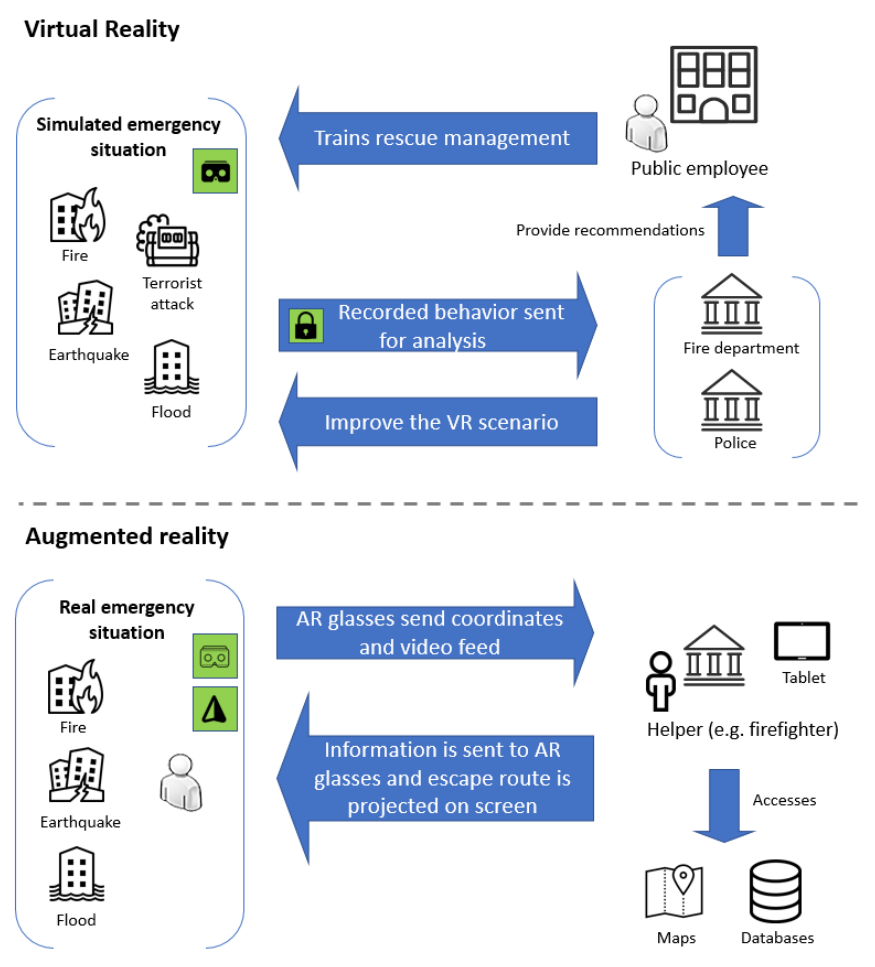
Figure 2. Scenario poster – “Virtual Reality and Augmented Reality for emergency training" As described in the methodology, the scenario provides an example of possible future implemen- tations of disruptive technologies in public service provision. While most of the relevant technolo- gies can be implemented today, there are still aspects that need to be developed further (e.g. room mapping technology (3D scanning and creation of virtual spaces based on real ones) is still costly to realise). The next two sections outline the main research and training needs (step 4 of the approach) extracted from the thirteen scenarios and informed from the analysis and synthesis in step